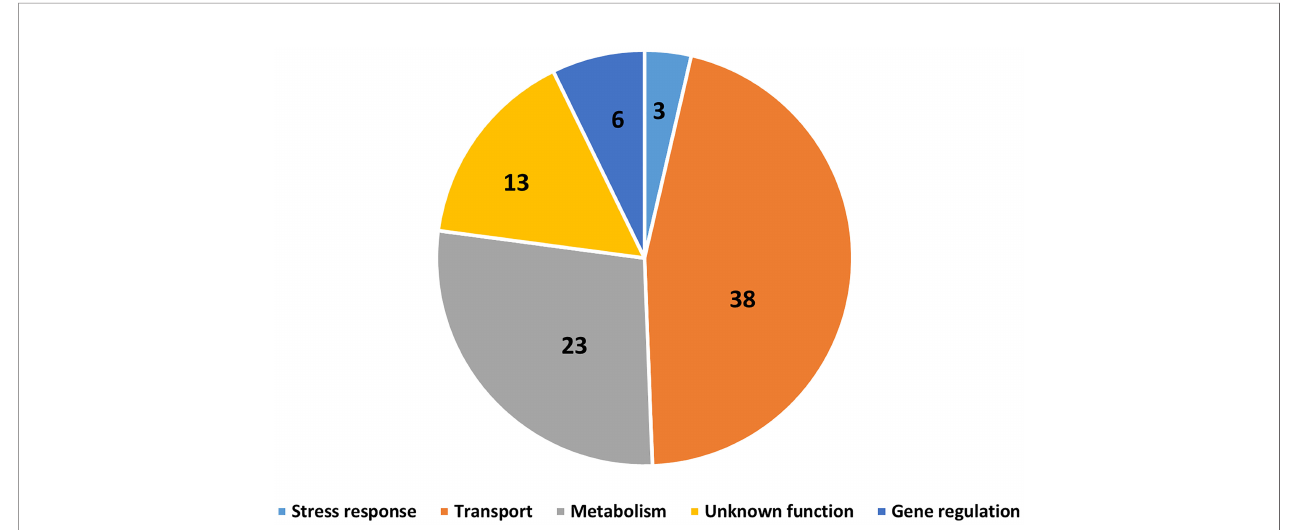
FIGURE 8 | Gene candidates that potentially contribute to Bordetella -amoebal interactions. By using GWAS approach, 83 genes which may contribute to the interaction between Bordetella spp. and amoebae were identi fi ed. The genes are categorized based on their annotated functions being related to transport, metabolism, gene regulation, stress response, and unknown.